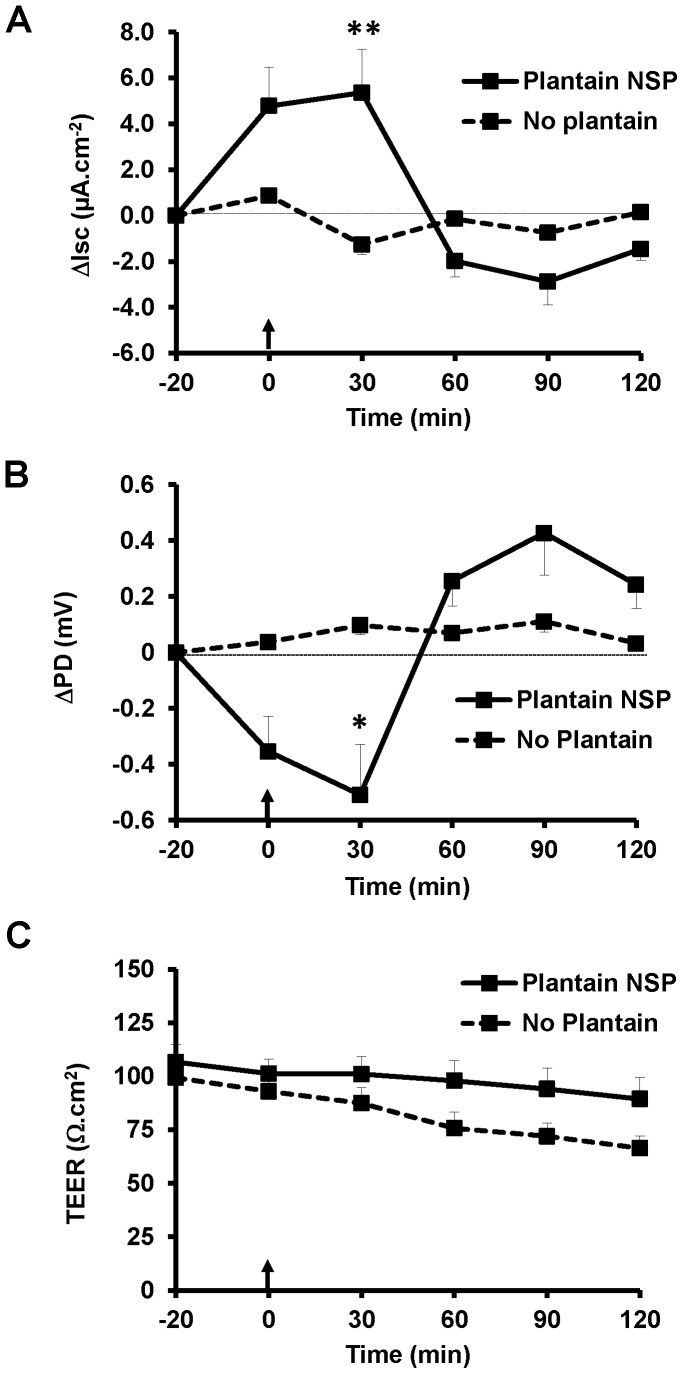
Soluble plantain NSP increases the transmucosal short circuit current of ex vivo human ileal follicle-associated epithelium.Plantain NSP (5 mg/mL) significantly increased (A) transmucosal short circuit current (Isc), with a concomitant decrease in (B) epithelial potential difference (PD, apical-side negative), during pre-treatment of, and blockade of translocation of S. Typhimurium across ex vivo human ileal follicle-associated epithelium (FAE) mounted in Ussing chambers. (C) Trans-epithelial electrical resistance (TEER) was maintained throughout the experiment. N = 4, with 2 tissue replicates in each case. * P<0.05, ** P<0.01, ANOVA. For each tissue, I
sc and PD responses were calculated and expressed as the increment change (Δ) for each sampling period. Arrows at T0 min indicate addition of EGFP-expressing S. Typhimurium LT2 to the mucosal compartment (1×108 CFU/mL). Overnight culture of Ussing chamber serosal medium following 2 h infection had already demonstrated soluble plantain fibre to block translocation of Salmonella across isolated human FAE in this experiment; see reference [21].